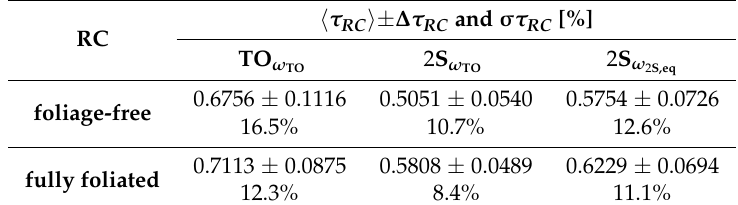
(cid:110) (cid:111) 2S ω ,2S ω during the TO 2S,eq